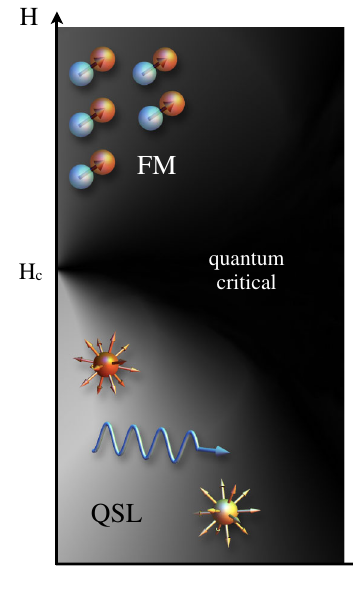
FIG. 3. Schematic phase diagram in the temperature ( T ) magnetic-field ( H ) plane, for a material in the QSL phase of Eq. (1) at T ¼ H ¼ 0 . At a low field and temperature, the QSL state supports exotic excitations: ‘‘magnetic’’ (red sphere) and ‘‘electric’’ (yellow sphere) monopoles, and an emergent photon marks a quantum critical point: the (wavy line). The field H c , the ground state is a confinement phase transition. For H > H c simple field-polarized ferromagnet (FM), and the elementary excitations are conventional magnetic dipoles. The gradations in gray scale indicate crossovers to the quantum critical region between them, governed by the T ¼ 0 confinement phase